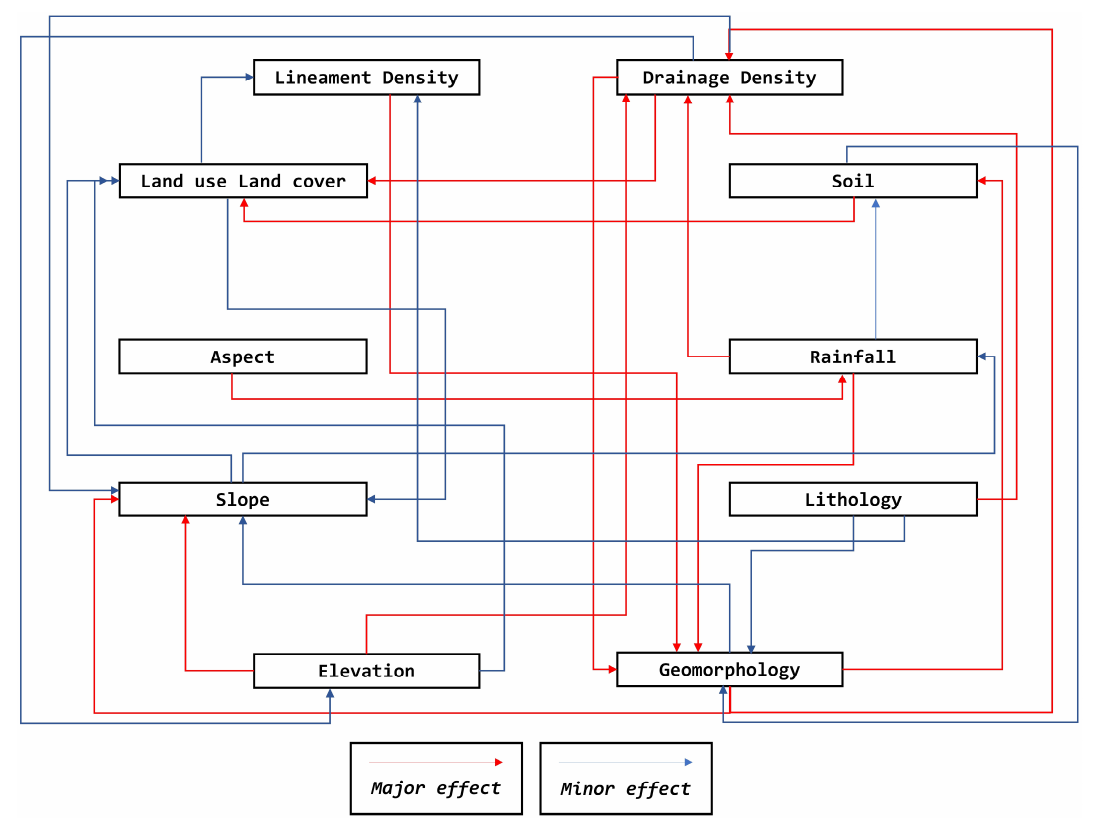
Figure 3. Diagram showing multi-influence factors for potential groundwater zones. Table 1. Impact of influencing factor, proposed score, and each potential factor’s relative